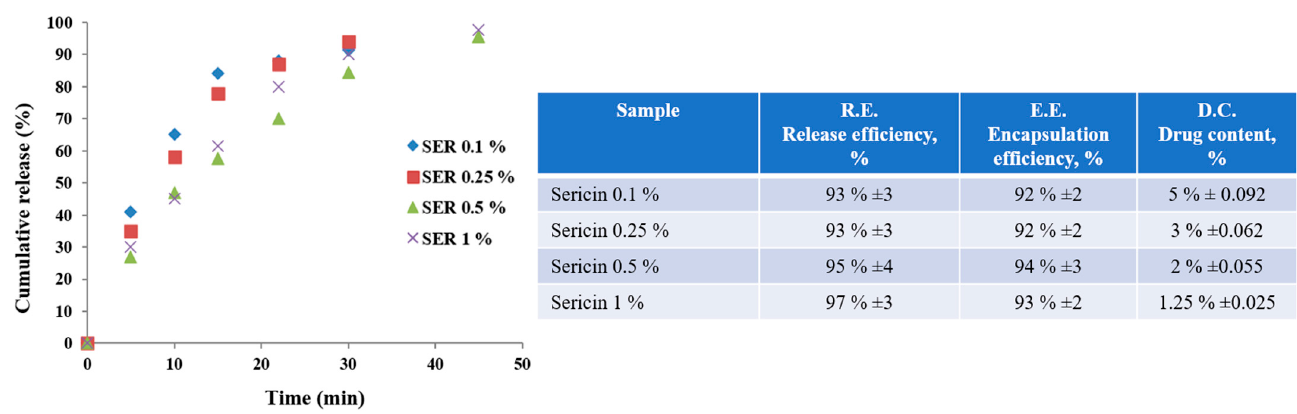
Figure 4. Doxorubicin release profile from sericin nanoparticles in acidic medium (pH 3) .